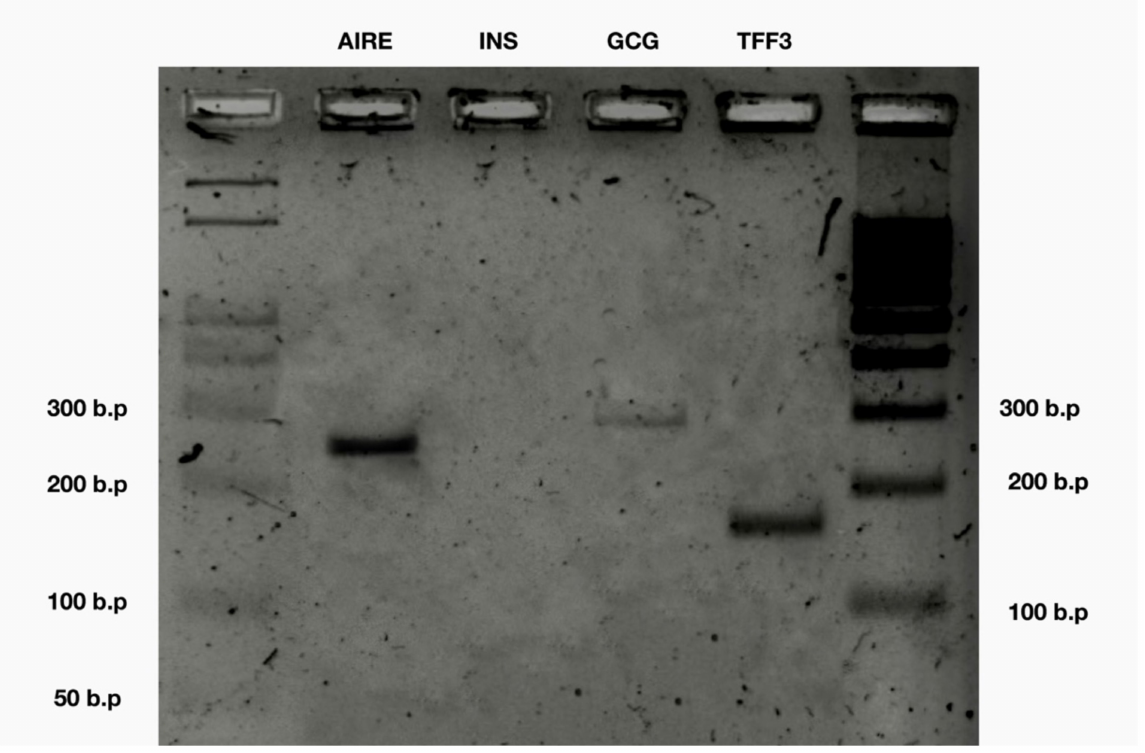
Figure 3. Agarose